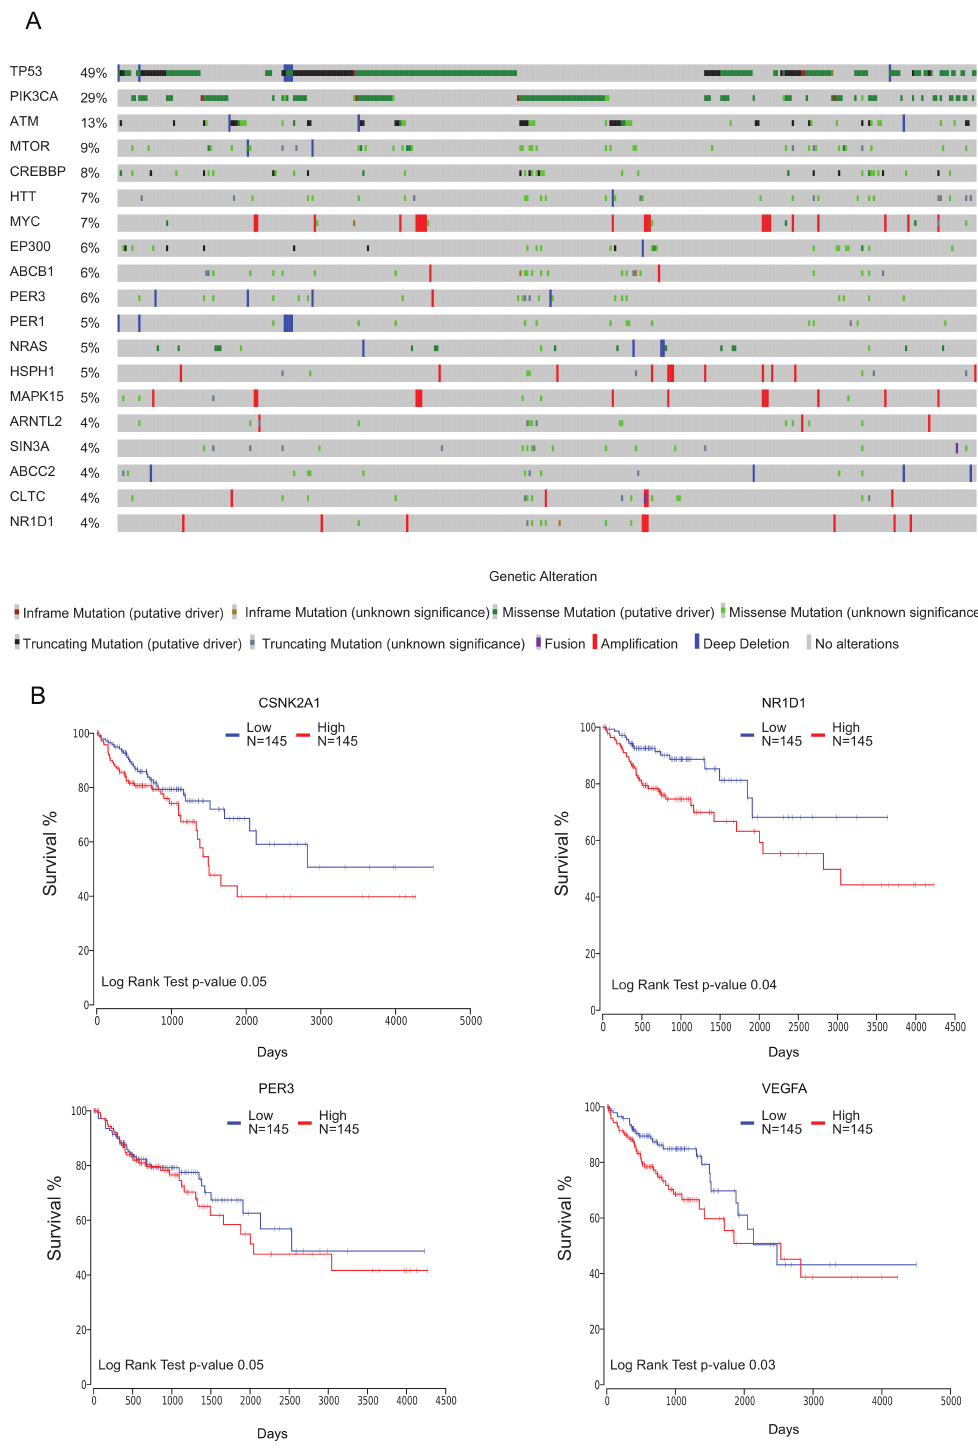
Figure 6. Mutational frequencies and impact of candidate genes on overall survival in TCGA COAD cohort ( A ) Oncoprint graphical summary of alterations in candidate genes that are mutated more than 4% of patients ( B ) Cox-regression based survival curves based on gene expression of candidate